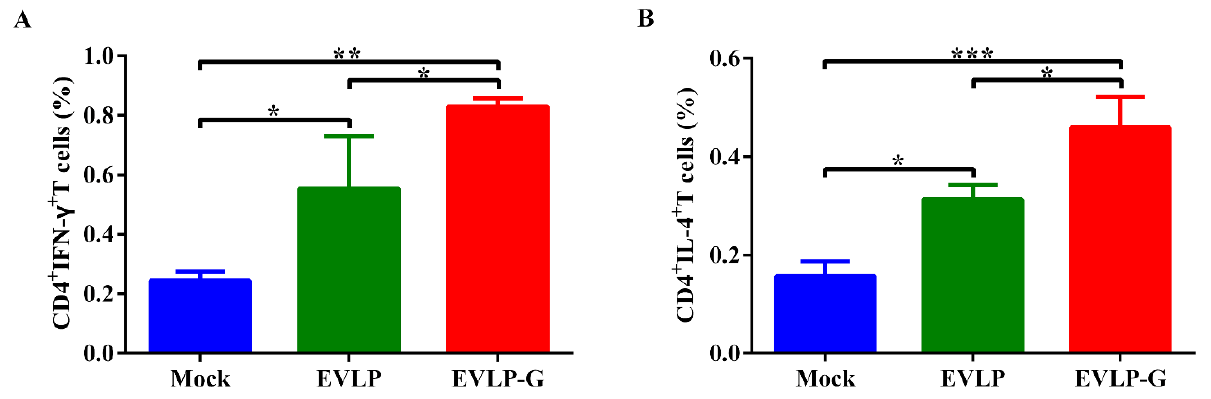
(* p < 0.05, ** p < 0.01, *** p <